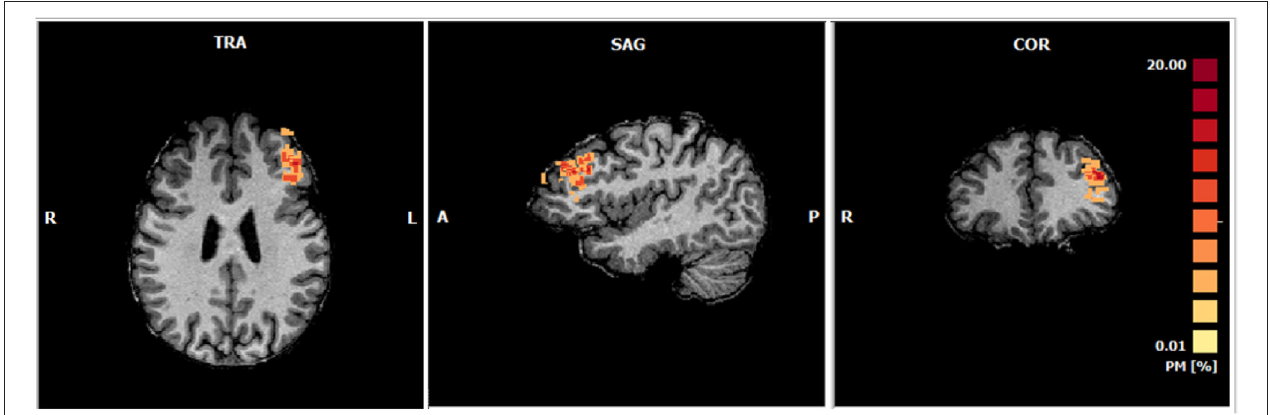
FIGURE 6 | Probabilistic maps of the ROIs selected online during the functional localizer of each subject (Talairach center of gravity mean coordinates: − 39.18 ± 2.93, 35.09 ± 7.66, 27.85 ± 7.53; Number of voxels: 393). The percentage of subjects in which each voxel was selected is represented accordingly to the color range from yellow to red.